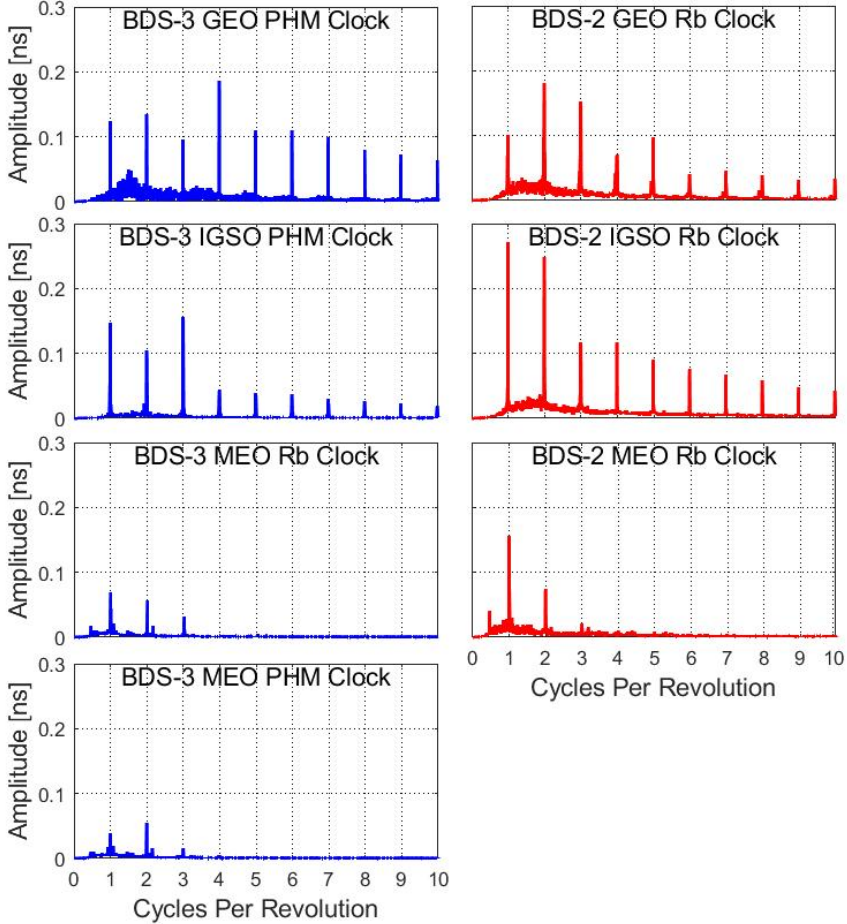
Figure 13. Averaged amplitude spectra of BDS satellite clock offsets.